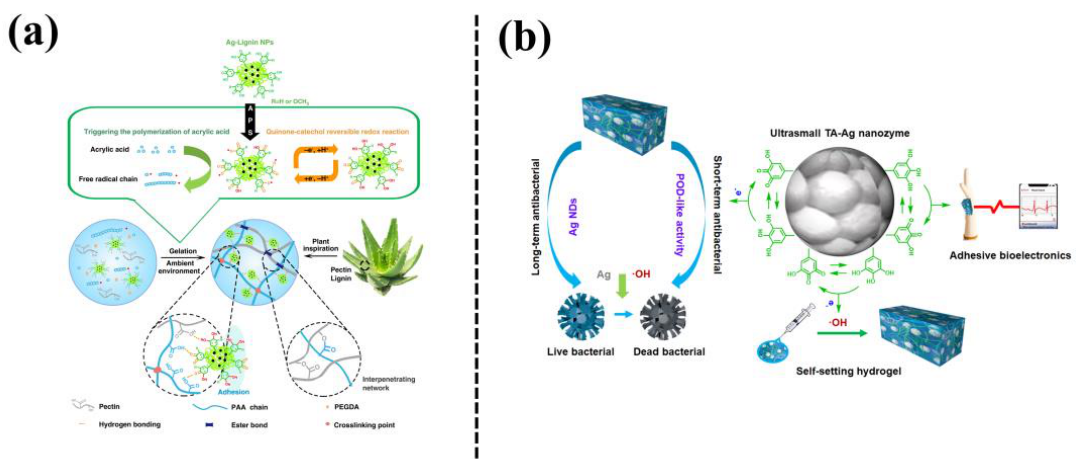
Figure 6. ( a ) Fabrication process of plant-inspired catechol-chemistry-based hydrogels by incorporation of the silver-lignin NPs to achieve self-adhesive, tough, and antibacterial properties [63]. ( b ) The TA-Ag nanozyme-loaded polyacrylic acid hydrogel (TA-Ag-PAA) with conductive and self-setting properties [64].